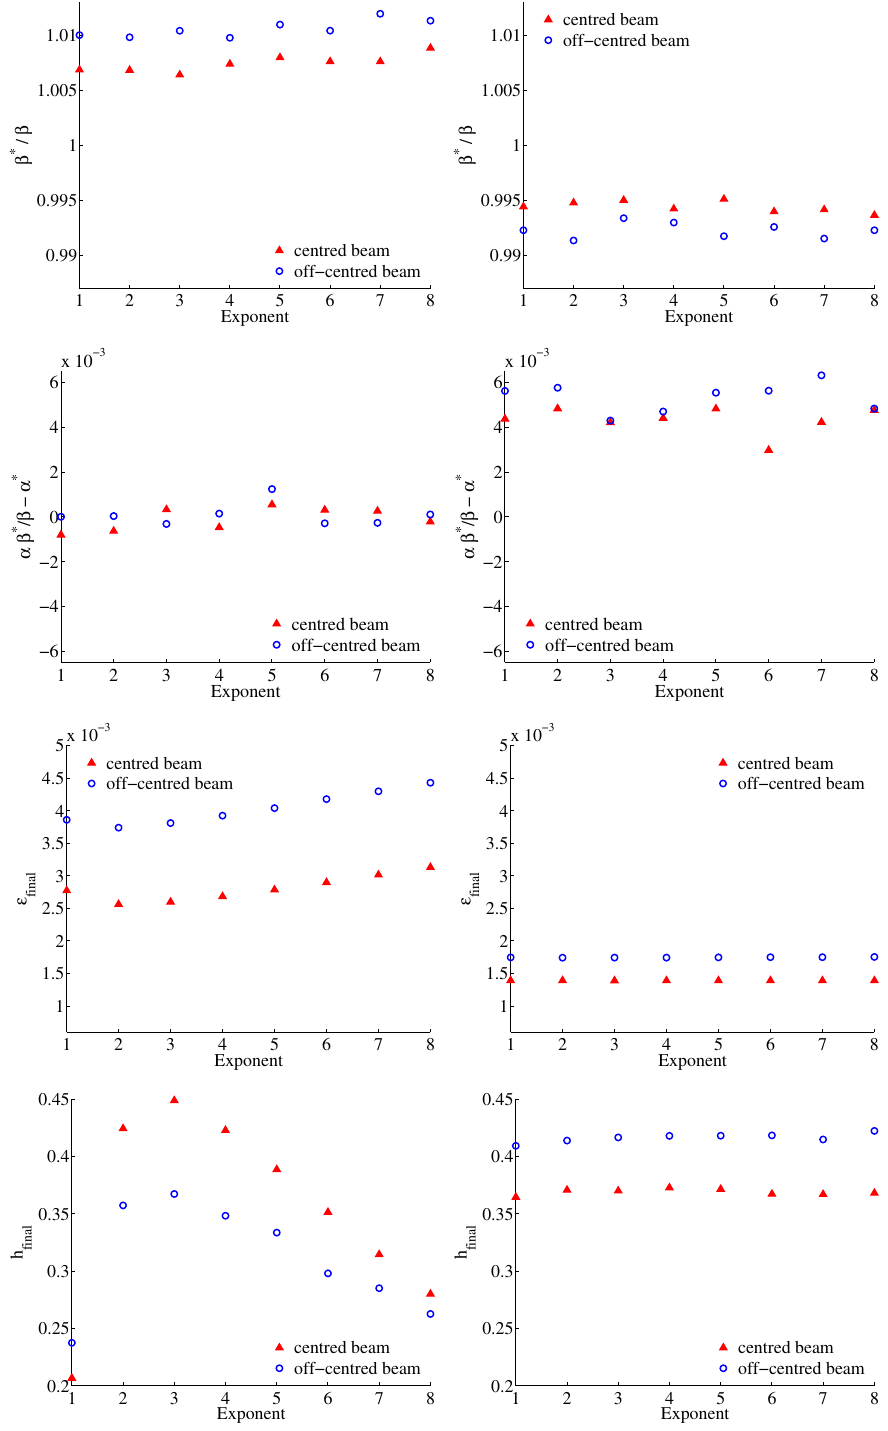
FIG. 9. (Color) Optical mismatch parameters, final emittance, and halo parameter as a function of the exponent p of the tune curve for the four-turn injection (left column) and for the three-turn injection (right column). The solid triangles correspond to injecting the beam at the center of the rightmost island, while the open circles to injecting the beam displaced from the island’s center. For the four- (cid:6) (cid:3) (cid:5) 0 : 255 ; 0 : 25 ; 0 : 248 (cid:6) [respectively (cid:5) 0 : 328 ; 0 : 333 ; 0 : 35 (cid:6) ], the ; (cid:3) ; (cid:3) turn injection (respectively three-turn) the tune values are (cid:5) (cid:3) a b c is 0 : 014 (respectively 0.017) and the displacement of the off-centered beam is (cid:1) ^ X (cid:3) 0 : 0176 (respectively constant value of (cid:8) initial (cid:6) (cid:3) (cid:5) 13 000 ; 500 ; 6500 (cid:6) and the number of initial conditions for each ; n ; n 0 : 0192 ). In both cases, the constant value of p is 1 , (cid:5) n 1 2 3 injected turn is 10 6